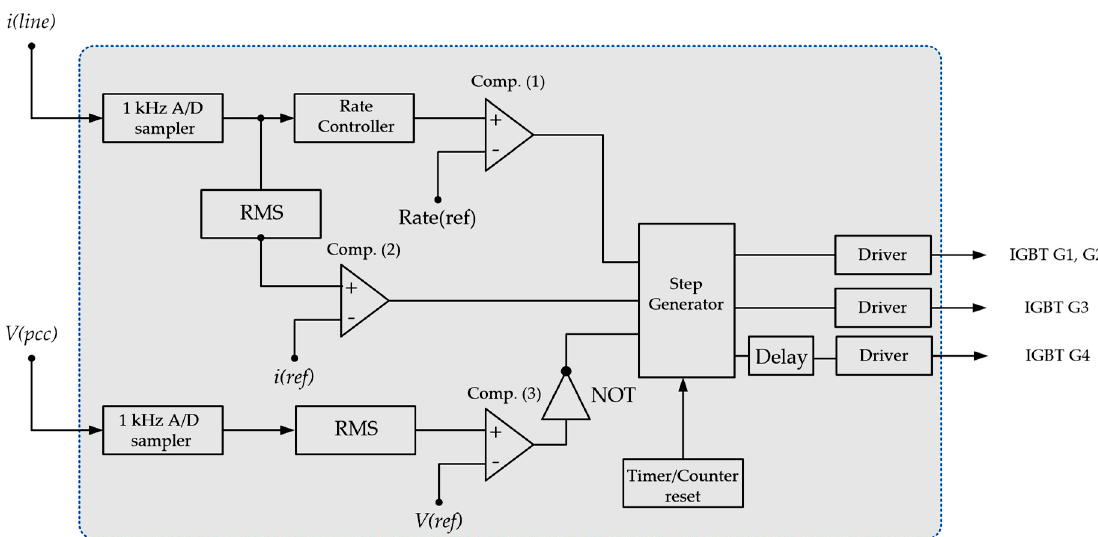
Figure 3. HBFCL control block